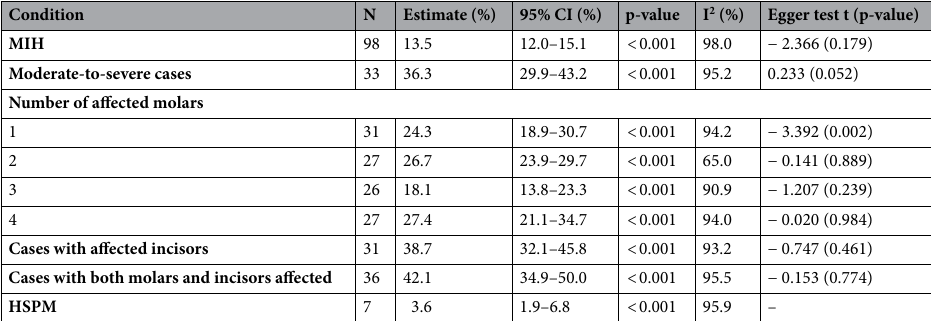
Table 2. Meta-analysis on the prevalence of MIH cases, severity of cases, number of affected molars, cases with affected incisors and HSPM. MIH Molar-Incisor Hypomineralization, HSPM Hypomineralization of the Second Primary Molars, 95% CI 95% Confidence